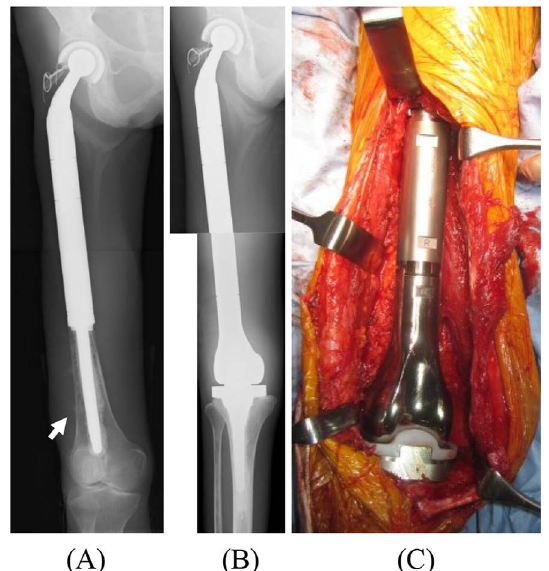
Figure 2. (A) X-ray of the right femur of 46-year-old woman with a local recurrence (arrow) of metastatic bone tumor from breast cancer after PFR. (B) Radiograph demonstrating the reconstruction of the right femur after TFR. (C) An intraoperative photograph after reconstruction of femoral bone using a